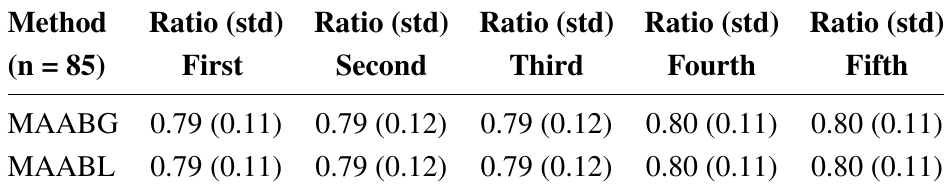
Table 1. Ratio averages of systolic blood pressure (SBP) measurements by the maximum amplitude algorithm using Bayesian with Gaussian (MAABG) and the maximum amplitude algorithm using Bayesian with Laplacian (MAABL); n = 85 is number of subject; std is standard deviation.